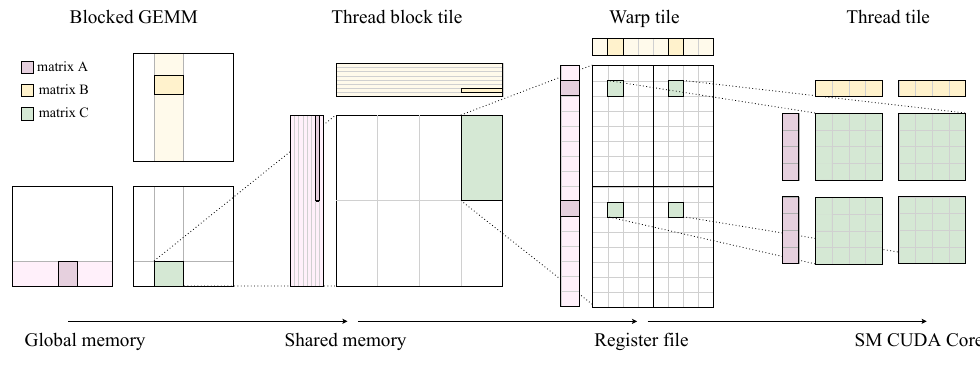
Figure 2. Cutlass GEMM hierarchy